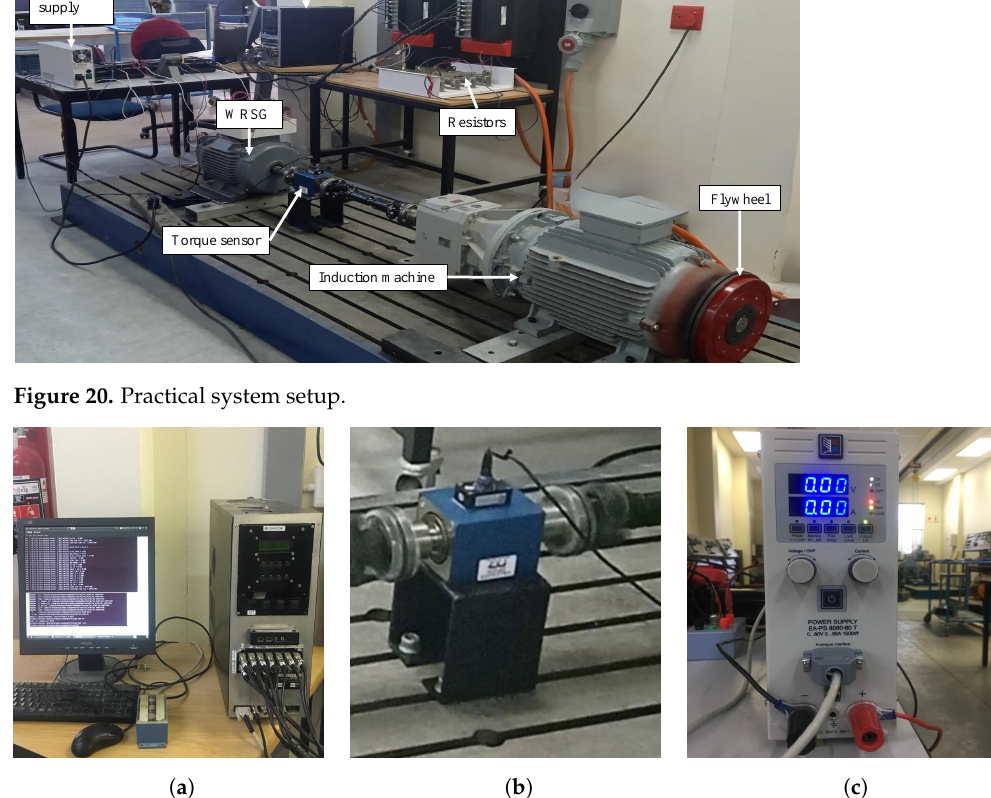
Figure 21. Photos of the ( a ) Pentium control system, ( b ) 80 V/60 A DC power supply, and ( c ) torque